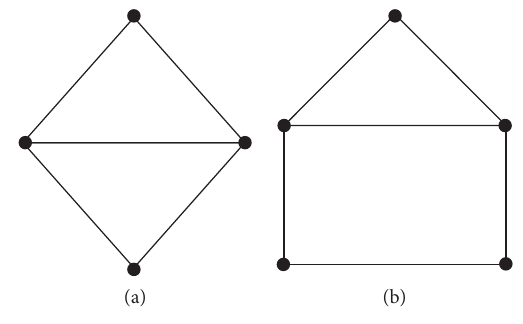
Figure 1: (a) Diamond. (b)